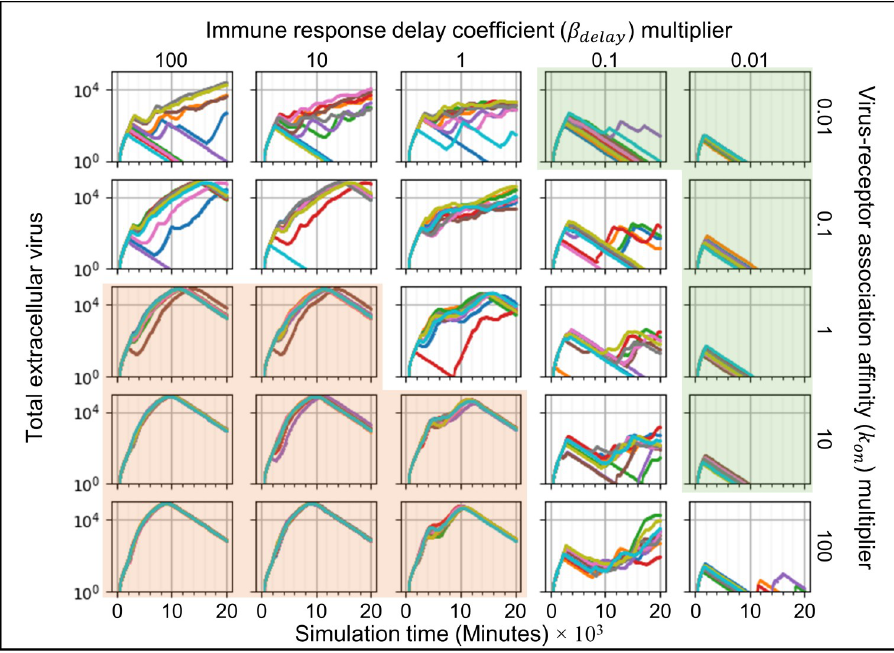
Fig 7. Sensitivity analysis of the total amount of extracellular virus vs time for variations in virus-receptor association affinity k on and immune response delay coefficient β delay , showing regions with distinct infection dynamics. Same parameter sweep as Fig 5. The total amount of extracellular virus for each simulation replica for each parameter set, plotted on a logarithmic scale, vs time displayed in minutes. See Fig 4 for the definitions of the classes of infection